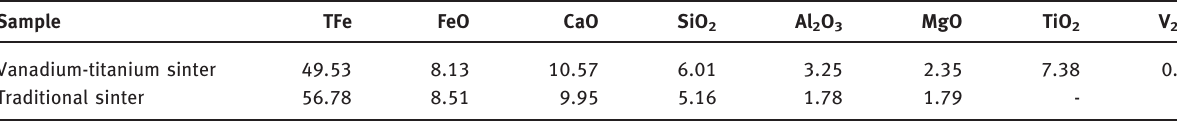
Table 1: Chemical compositions of the sinters (mass %). Sample TFe